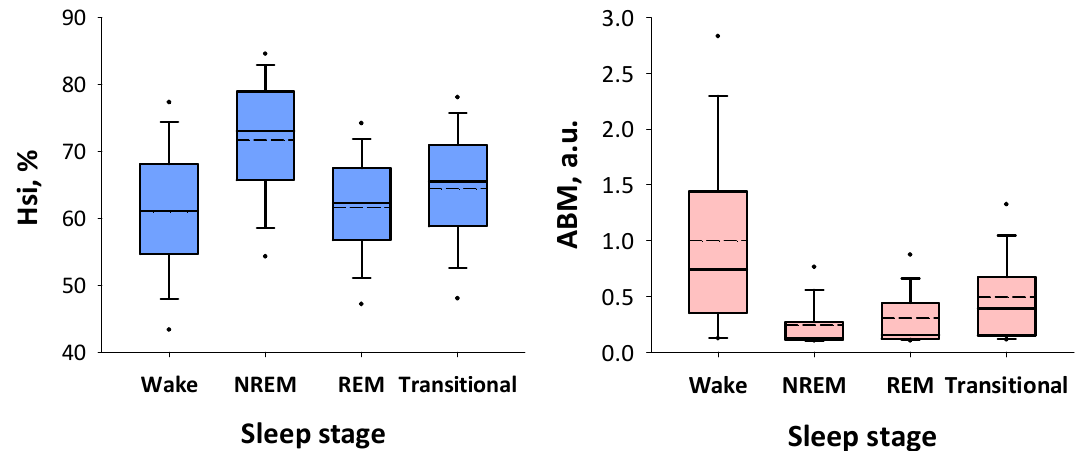
Figure 4. Hsi and ABM for each sleep stage. Each box shows IRQ range, solid and dashed horizontal lines within box show median and average, error bars show 10 and 90 percentiles, and dots show 5 and 95 percentile values. Hsi is higher during NREM than wake, REM, and transitional stages and ABM is greater during wake than NREM and REM stages ( p < 0.0001 for all).